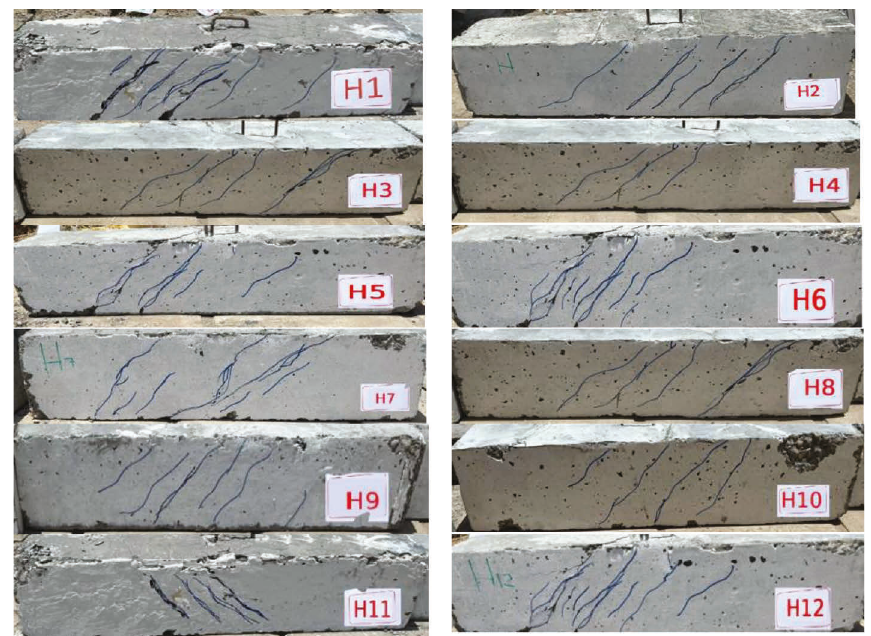
Figure 16: Failure mode of the tested